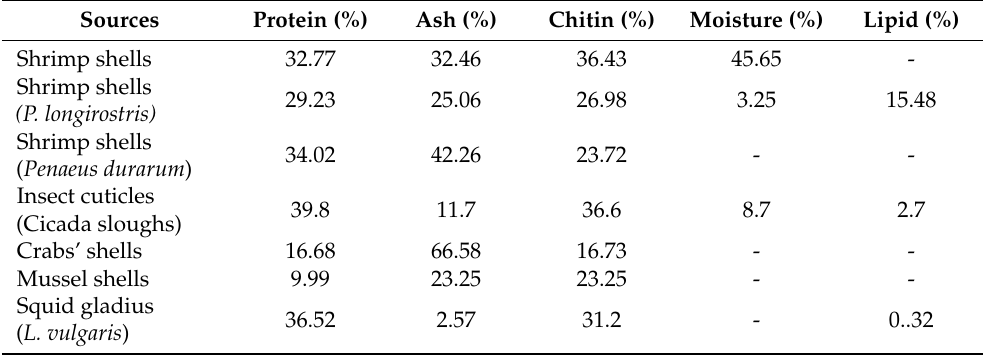
Table 1. Proximate composition of different chitin sources